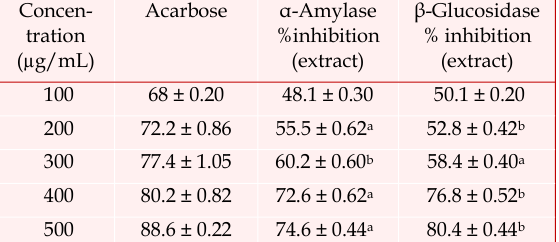
Inhibitory activity of α - amylase and β - glucosidase for extract and standard at different concentrations